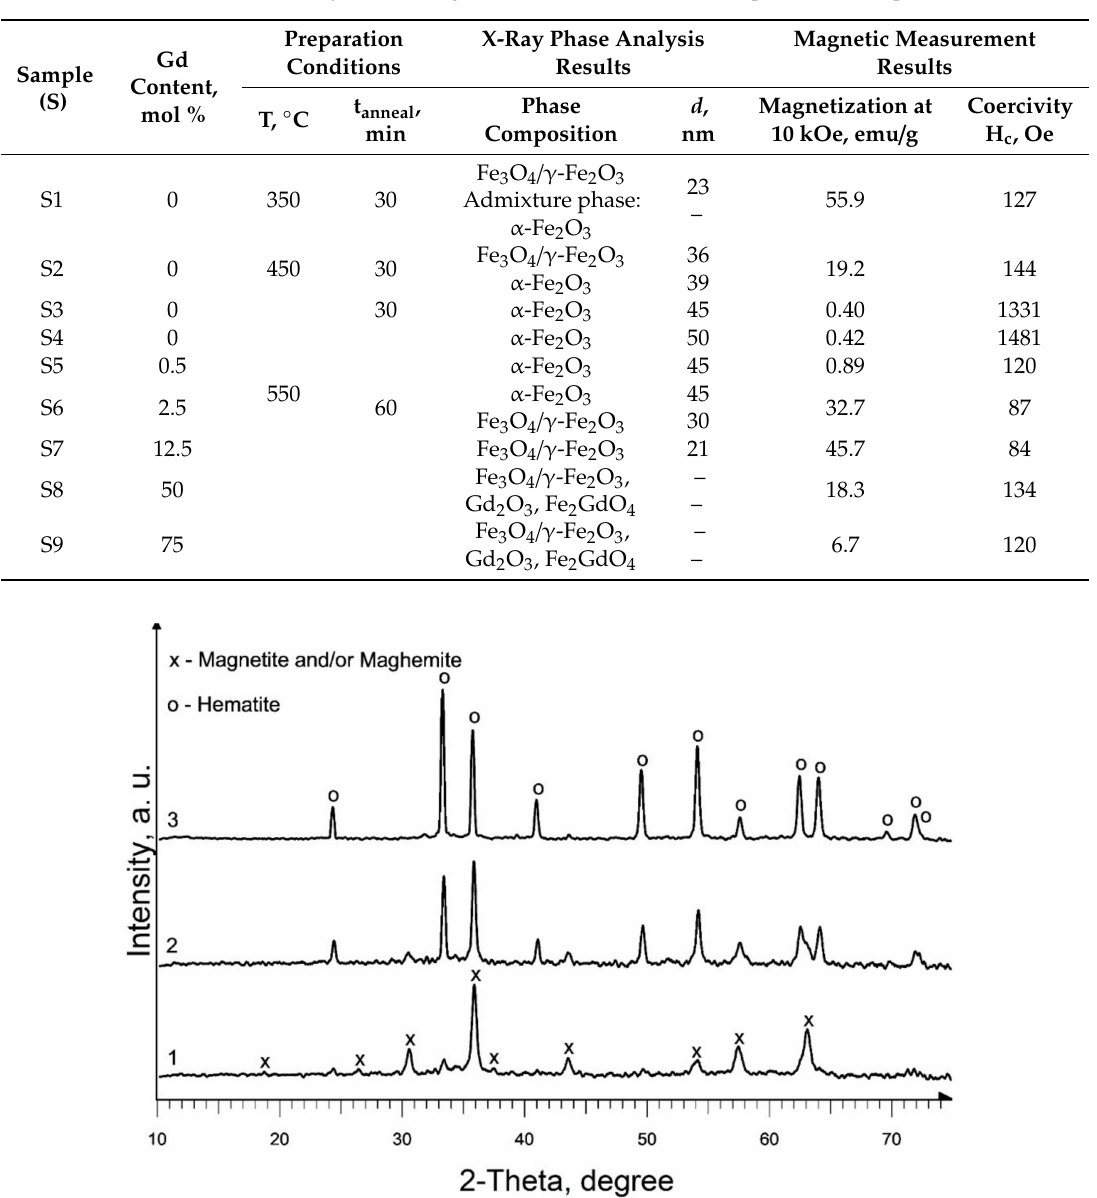
Table 1. XRD analysis and magnetic measurement results of produced samples.